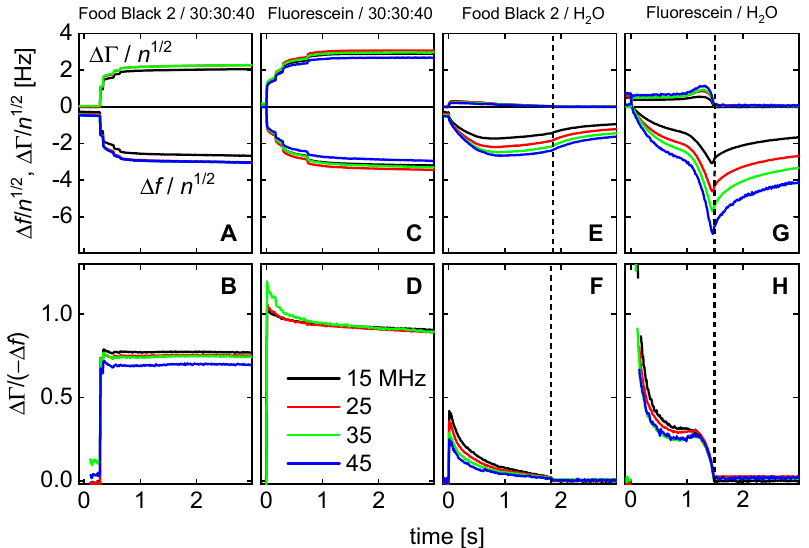
Figure 4. Data extracted from ∆ f ( n ) and ∆Γ ( n ) as described in Section 3.3. The dye concentrations Figure 4. ( Top ) Shifts of frequency and bandwidth for the impact of an individual droplet from the were between 0.5 and 10 wt%. The third droplet impact was chosen for display. ( A ) The ratio ∆Γ / ( − ∆ f ) four types of solutions indicated in the titles. Δ f and ΔΓ have been normalized to n 1/2 because this averaged over the 4 overtones. ( B , C ) Prefactors A ∆ f and A ∆Γ obtained by fitting power laws to ∆ f ( n ) scaling makes the data from different overtones overlap. The dye concentrations were 0.5 wt% (Food and ∆Γ ( n ). The prefactors are related to the wetted area. ( D , E ) Power-law exponents α (cid:48) and α ” Black 2) and 1.5 wt% (fluorescein) in water and 30:30:40. For the 30:30:40-fluid, drying is slow (>20 s). (see Equation (4)). The power-law exponents would be 1 / 2 for the semi-infinite Newtonian liquid. Droplets based on water dry out in less than 2 s. ( Bottom ) The ratio ΔΓ /( −Δ f ) always decreases with ( F ) The log-log plot of A ∆ f . The dashed line indicates the prediction following Tanner’s law time. (droplet radius scales as t 1 / 10 , droplet area scales as t 1 / 5